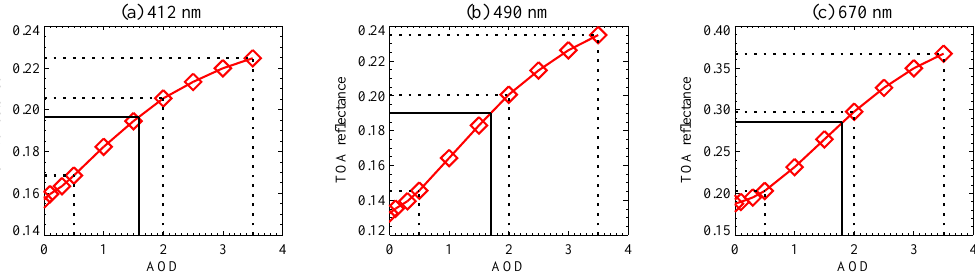
Fig. 5. Response of TOA reflectance to changes in AOD at (a) 412nm, (b) 490nm, and (c) 670nm. Geometry, surface and aerosol micro- physical properties were taken as those typically encountered at Banizoumbou by SeaWiFS. The red line indicates the TOA reflectance as a function of AOD at that wavelength. The black dotted lines show the TOA reflectance for AOD of 0.5, 2 and 3.5. The black solid line shows the average of reflectances for AOD=0.5 and AOD=3.5, and the equivalent AOD for this